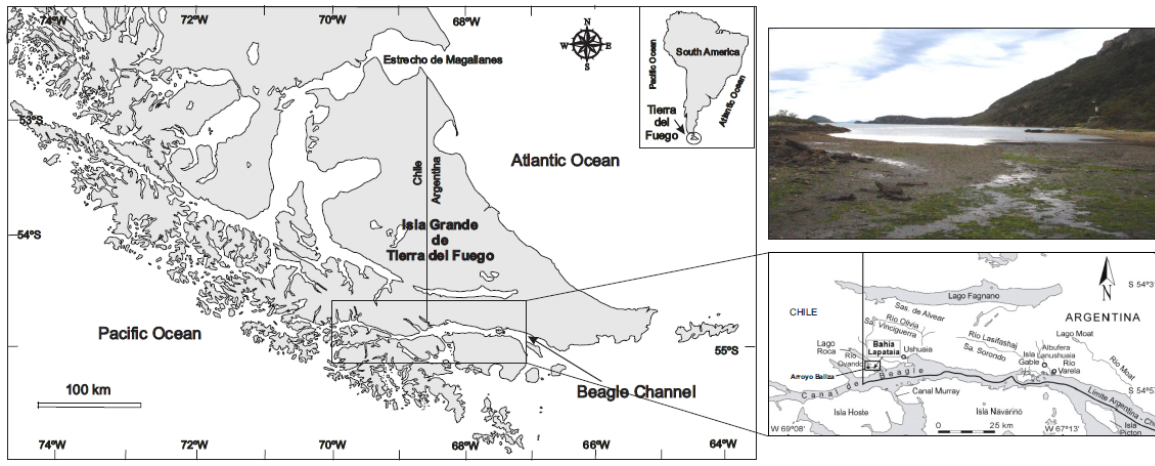
Figure 1. Location map of the study area and sampling section of Arroyo